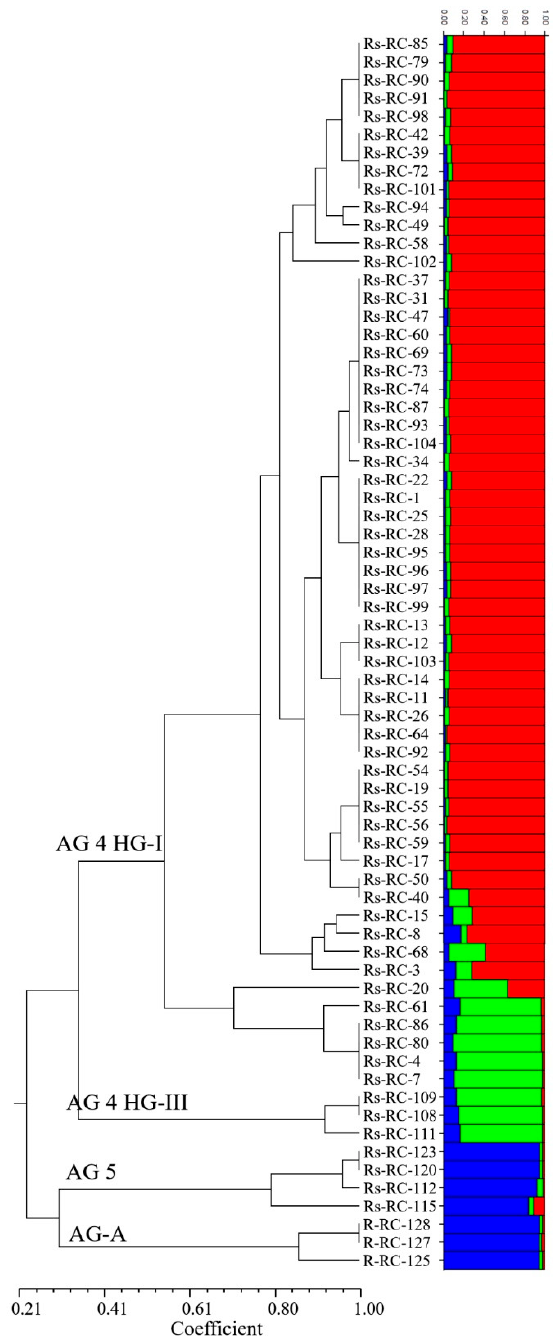
Figure 3. UPGMA tree based on iPBS combined data matrix for 68 Rhizoctonia isolates. Each individual is represented by a horizontal bar broken into different colored genetic clusters, with length proportional to the probability of assignment to each cluster.